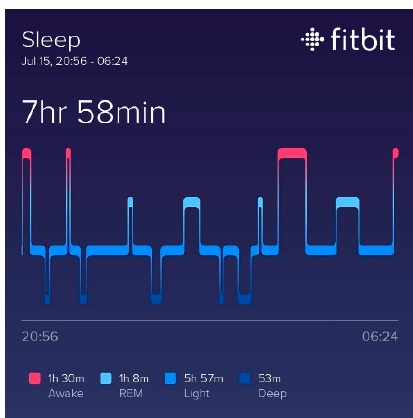
Figure A23. Phuket, Thailand.